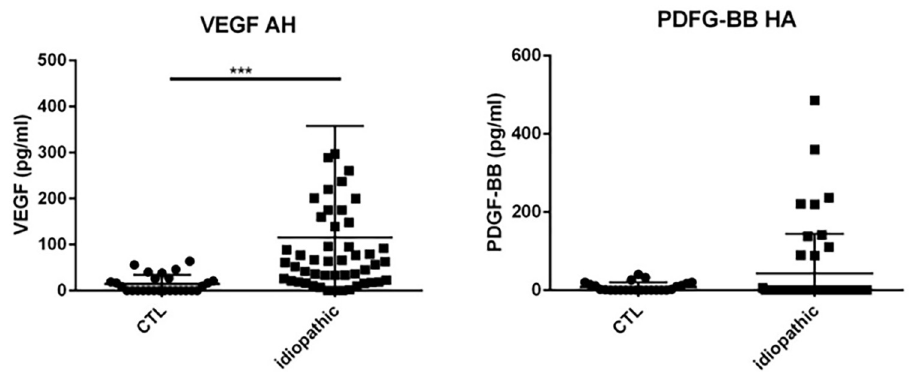
Fig 7. Dot plots of immune mediators: VEGF and PDGF-BB, in aqueous humor of patients with idiopathic uveitis (N = 64) as compared with immune mediators in the aqueous humor of noninflammatory controls patients (cataract age-related) (N = 36). Note that few isolated patients with idiopathic uveitis had an immune mediator elevated. � = P < 0.05 ; �� = P < 0.01; ��� = P < 0.001.